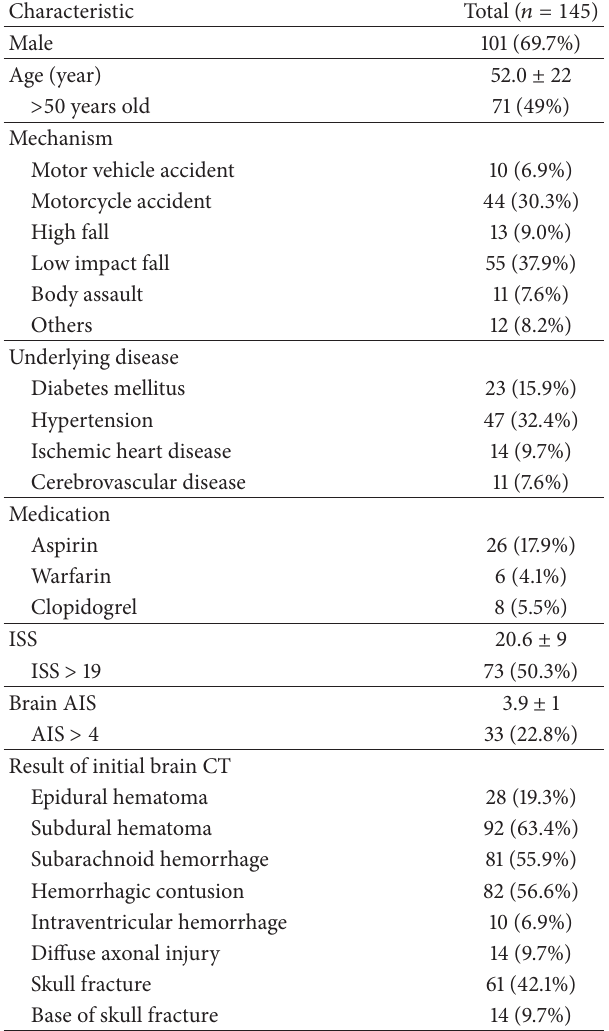
Table 1: Demographic and clinical